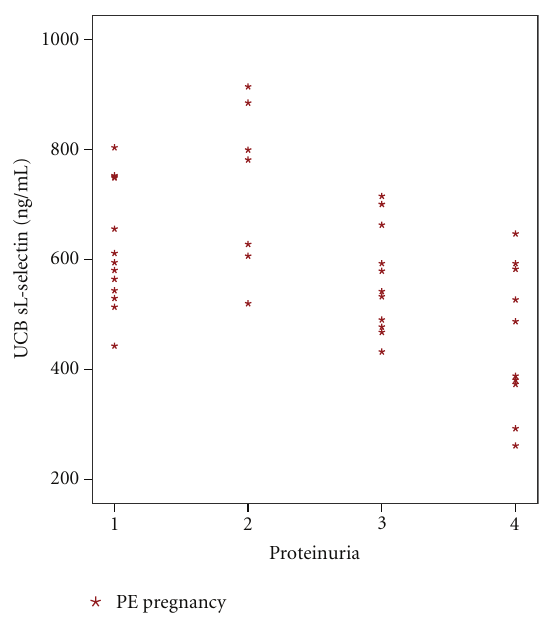
Figure 3: Correlation between maternal proteinuria and UCB sL- selectin, in PE (Spearman’s correlation coe ffi cient, − 0.45; P = 0 .